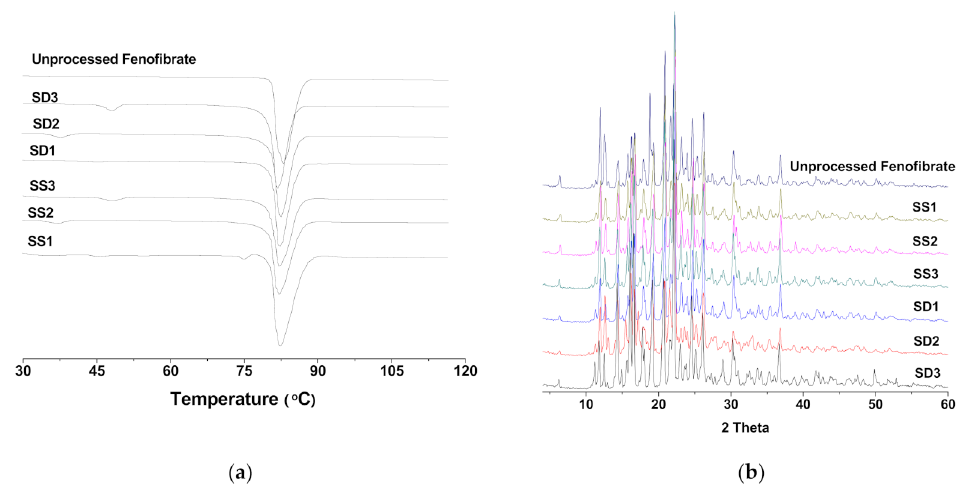
Figure 2. ( a ) DSC thermograms and ( b ) X-ray diffraction patterns of the SA-SD-processed and the SD-processed fenofibrate surface-active additive microcomposite particles.